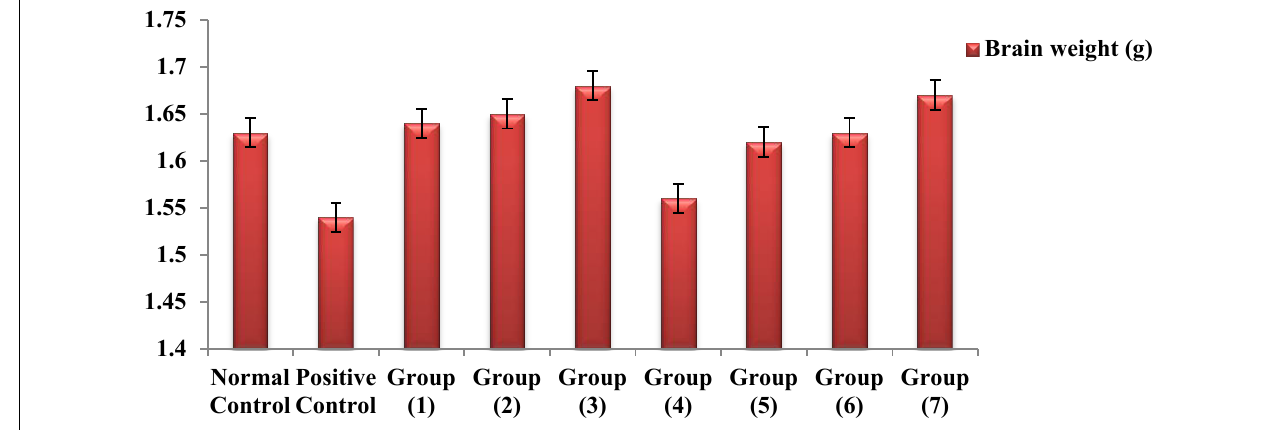
FIGURE 5 | Effects of the RB, BR, and SL complex microcapsules and UF cheese with complex coacervates on the brain weight of rats.